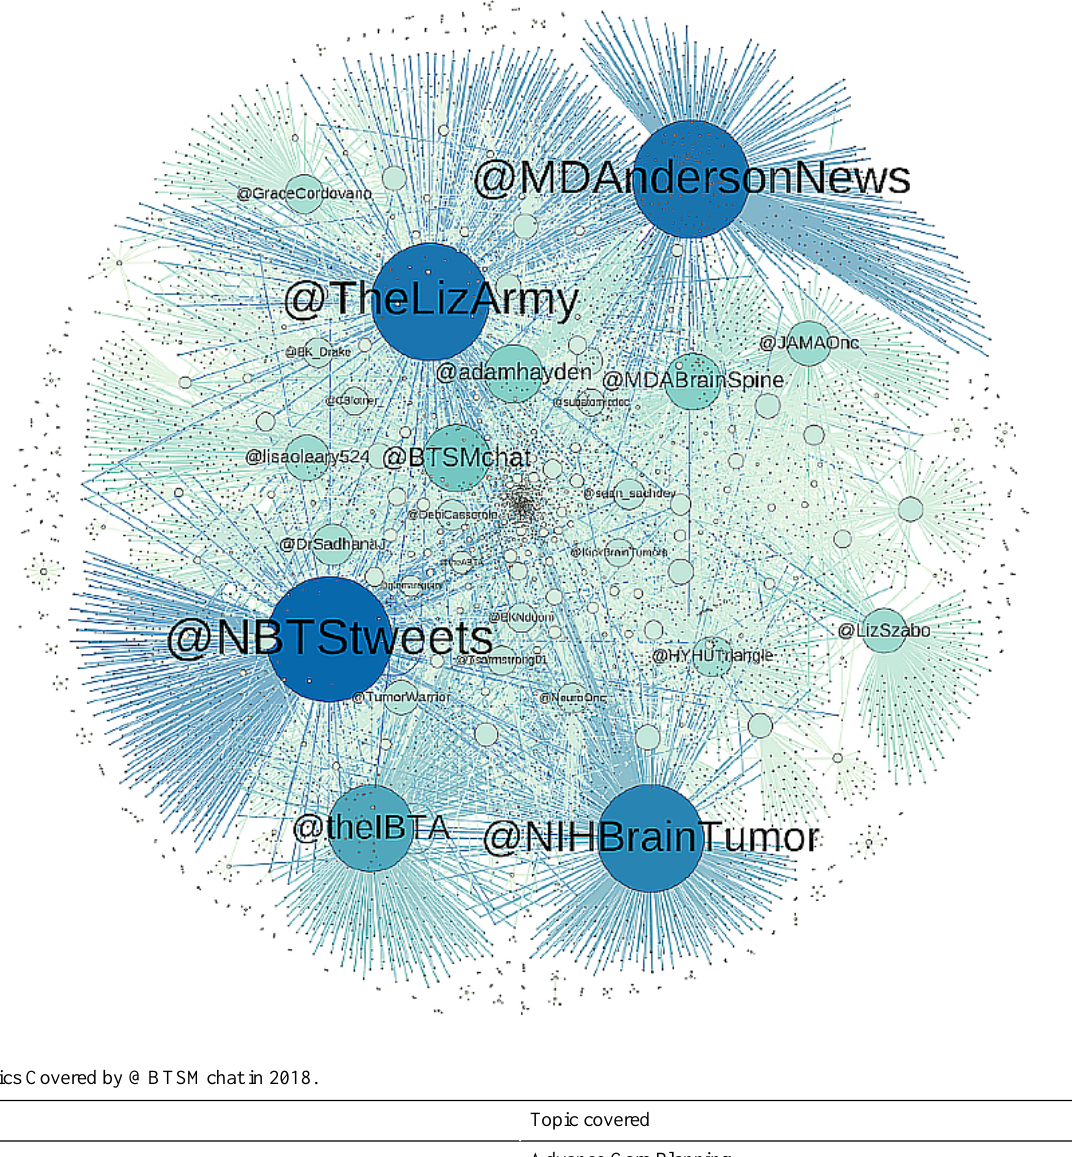
Figure 3. Social networks of most connected #BTSM users in 2018, by retweets.